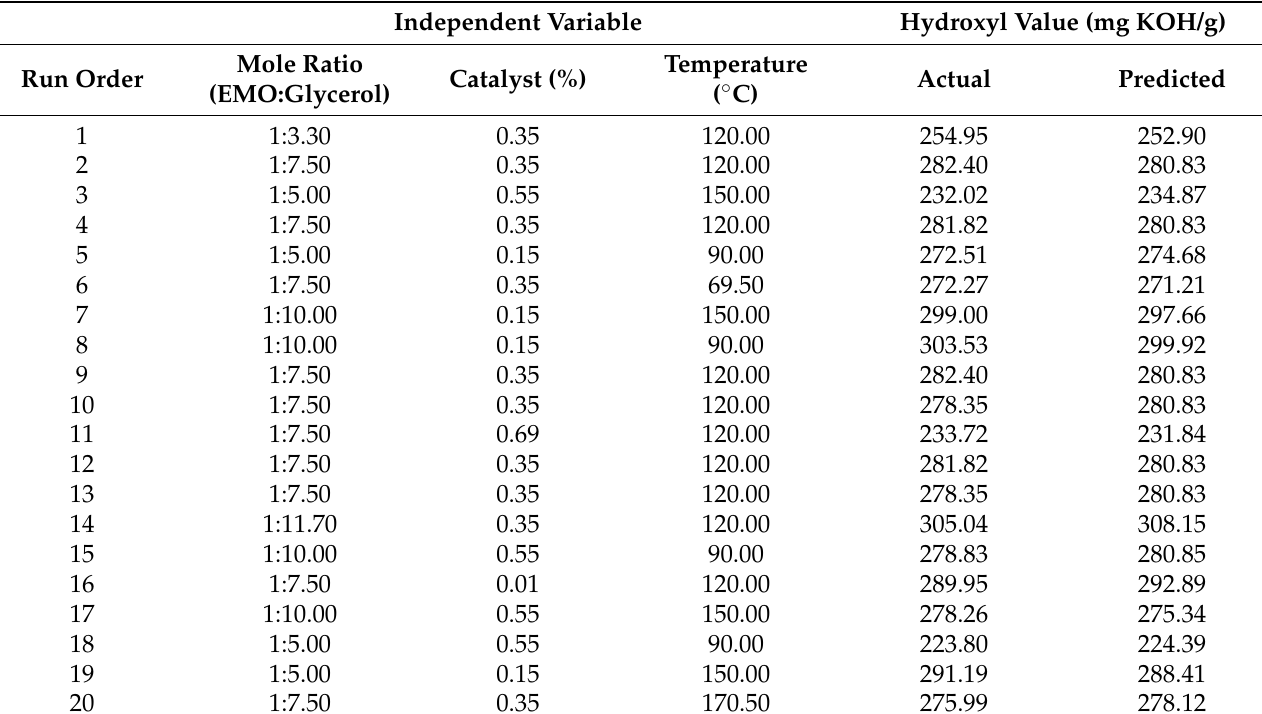
Table 1. Experimental data of actual and predicted values of hydroxyl value of